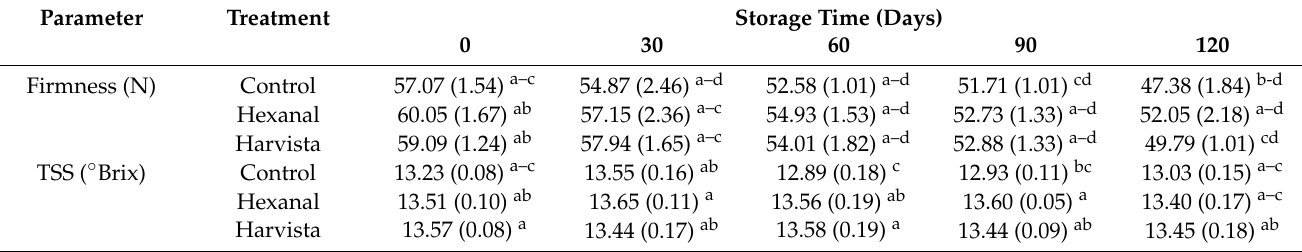
Table 2. Variation in firmness and TSS in ‘Honeycrisp’ apples throughout the storage.